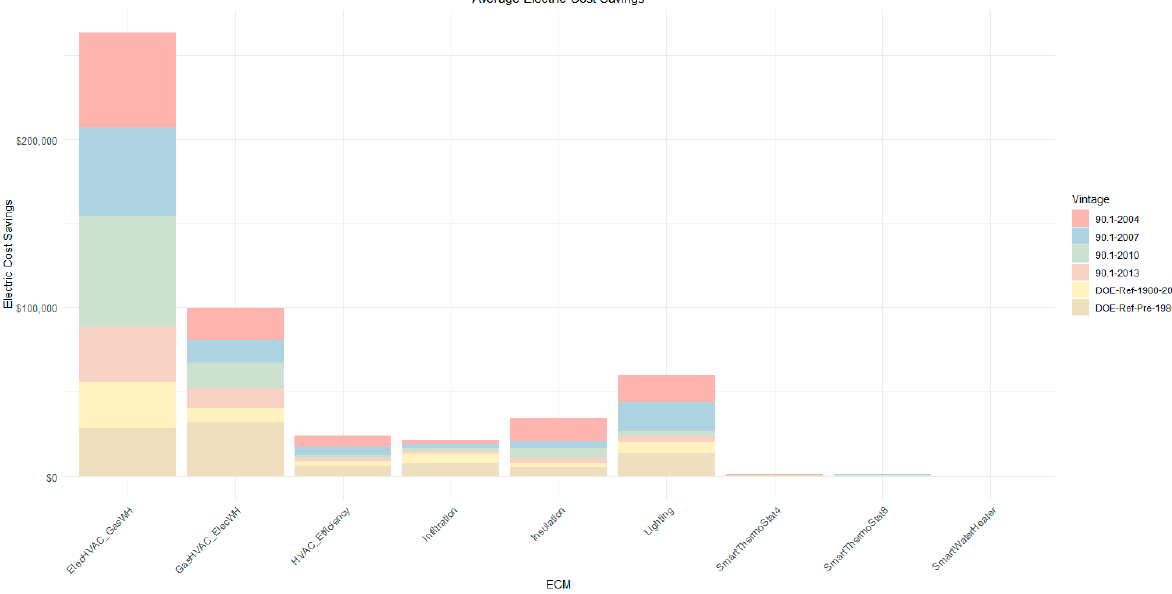
Figure 17. Average energy-related electricity cost savings potential by building vintage indicates significant savings opportunities. By combining building type and vintage for energy and demand, an initial estimate of cost savings can be used to determine if purchase and installation of these technologies may be cost-effective.